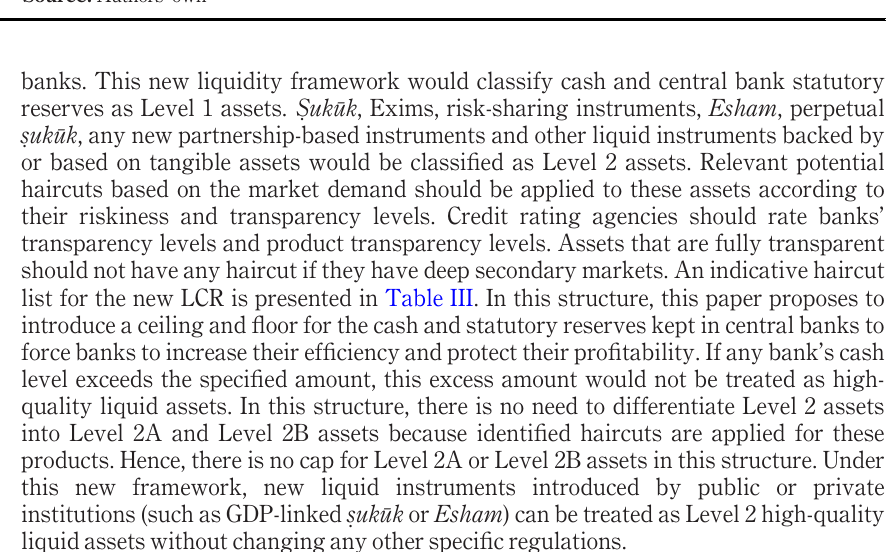
Table II. Minimum and maximum threshold for new LCR